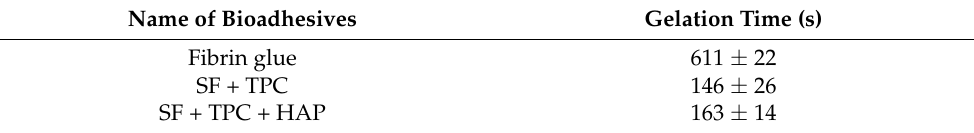
Table 2. Gelation time(s) of fibrin, SF + TPC, and SF + TPC + HAP.